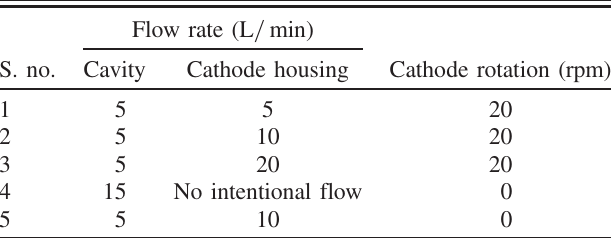
TABLE III. Conditions of acid flow in the nine-cell cavity and cathode housing under dual flow.